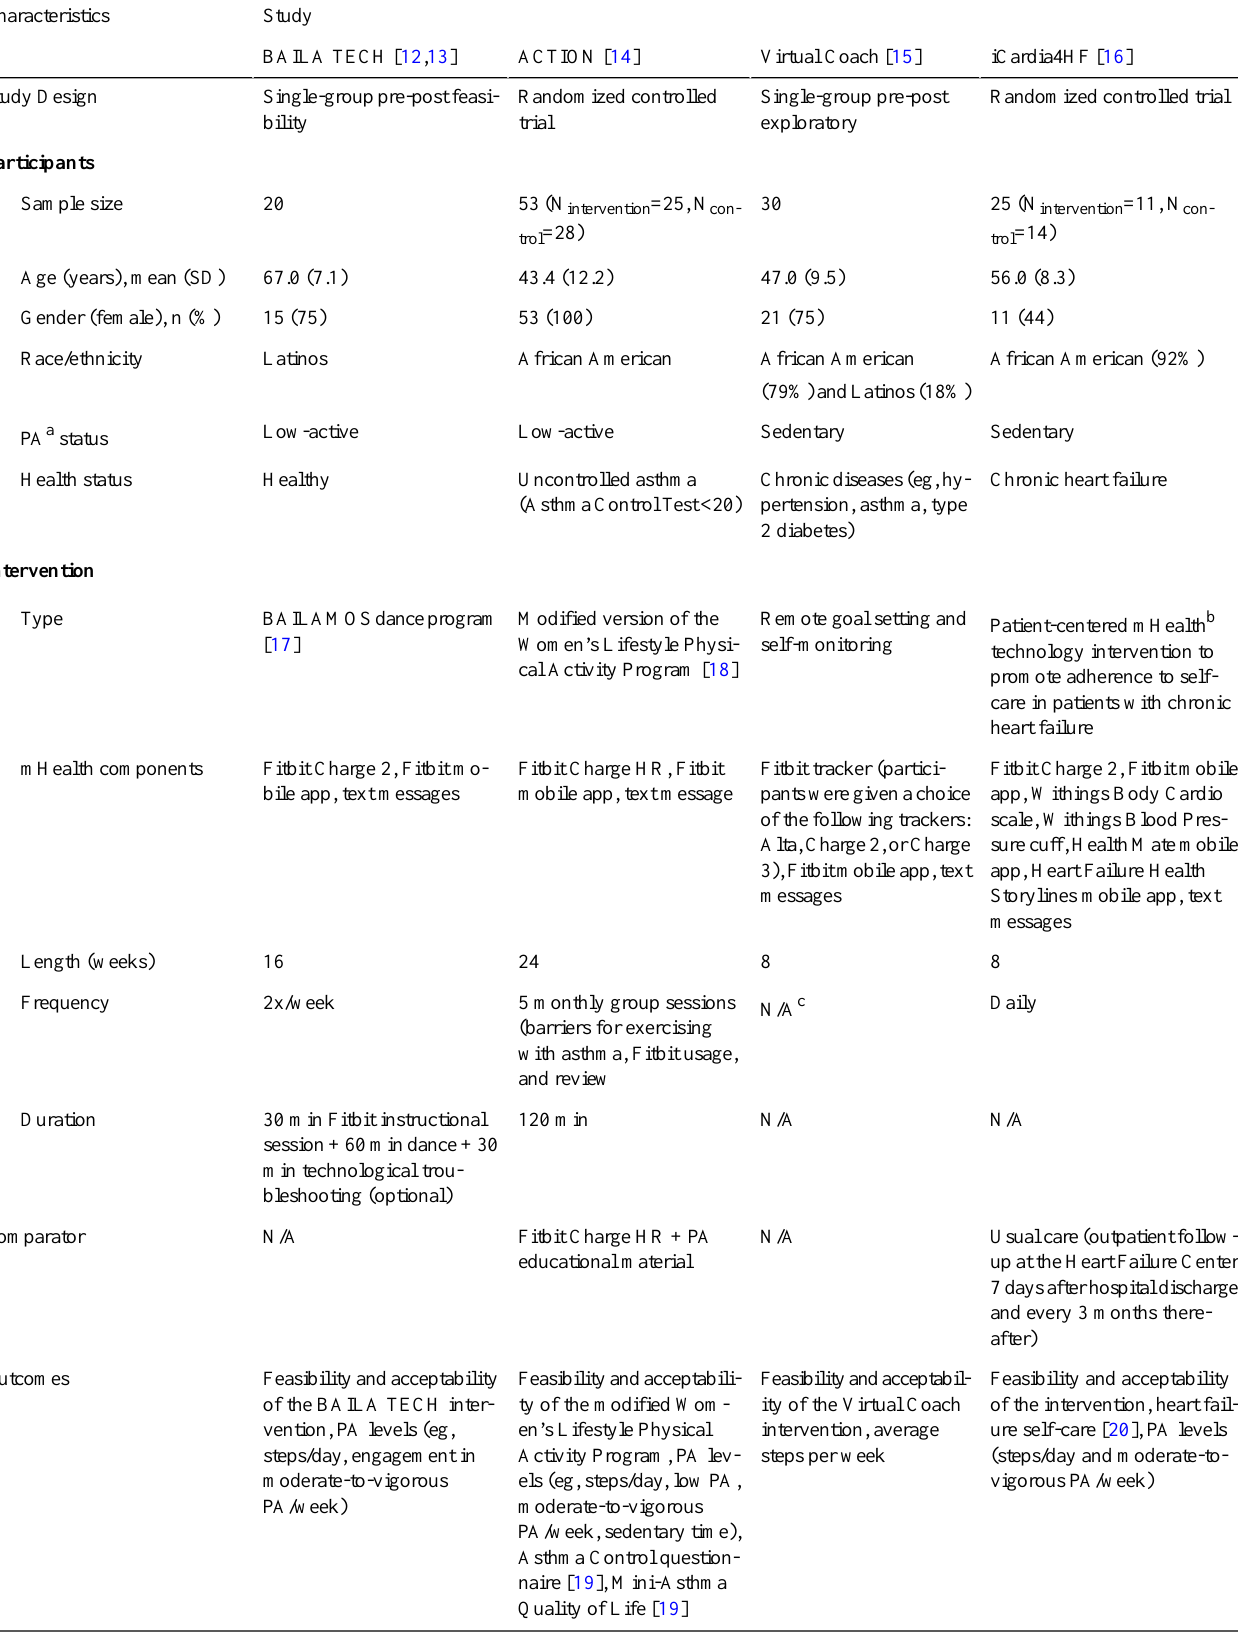
Table 1. Characteristics of the studies.